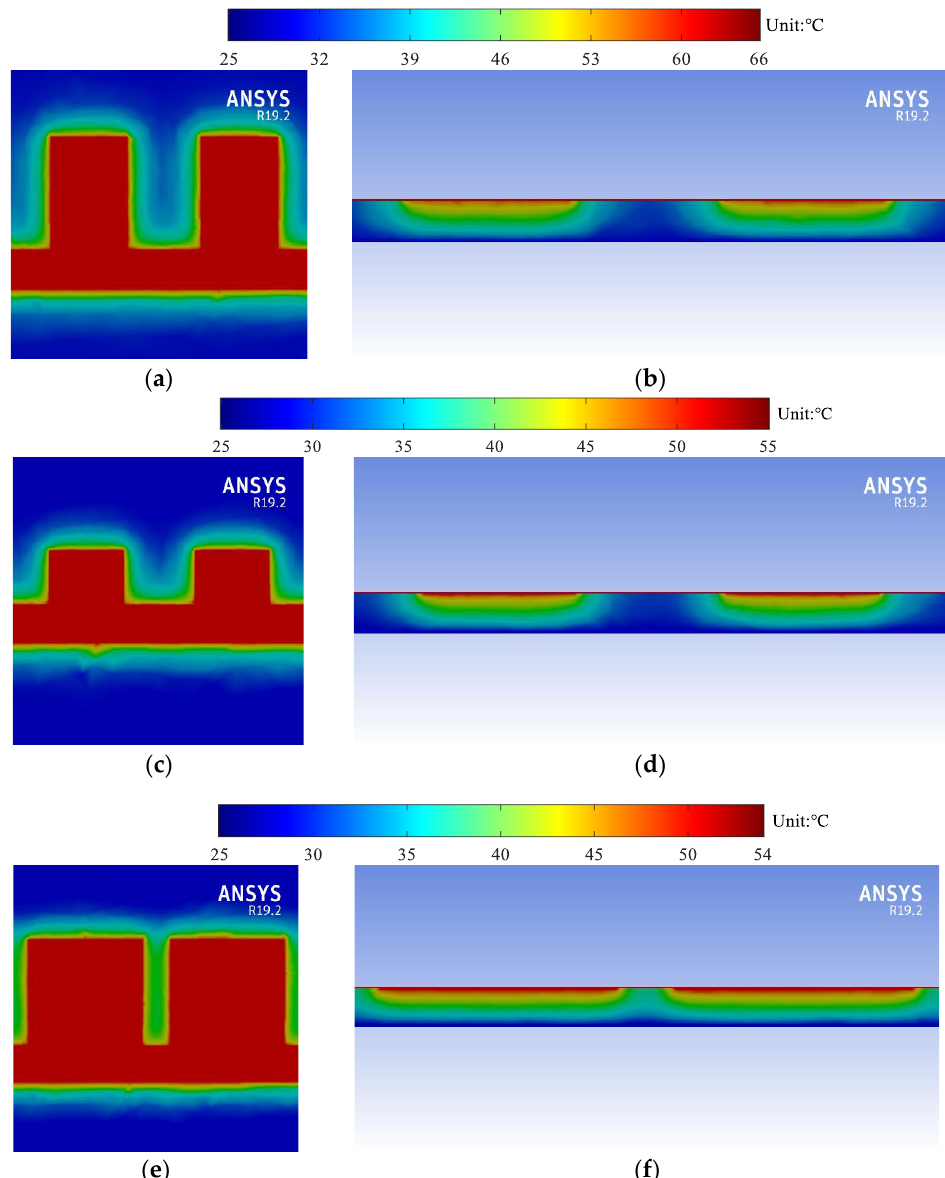
Figure 10. Simulated thermal profile of the U-shaped corrugated SWTLs: ( a ) top view of sample 1; ( b ) cross-sectional view of sample 1; ( c ) top view of sample 2; ( d ) cross-sectional view of sample 2; ( e ) top view of sample 3; ( f ) cross-sectional view of sample 3.